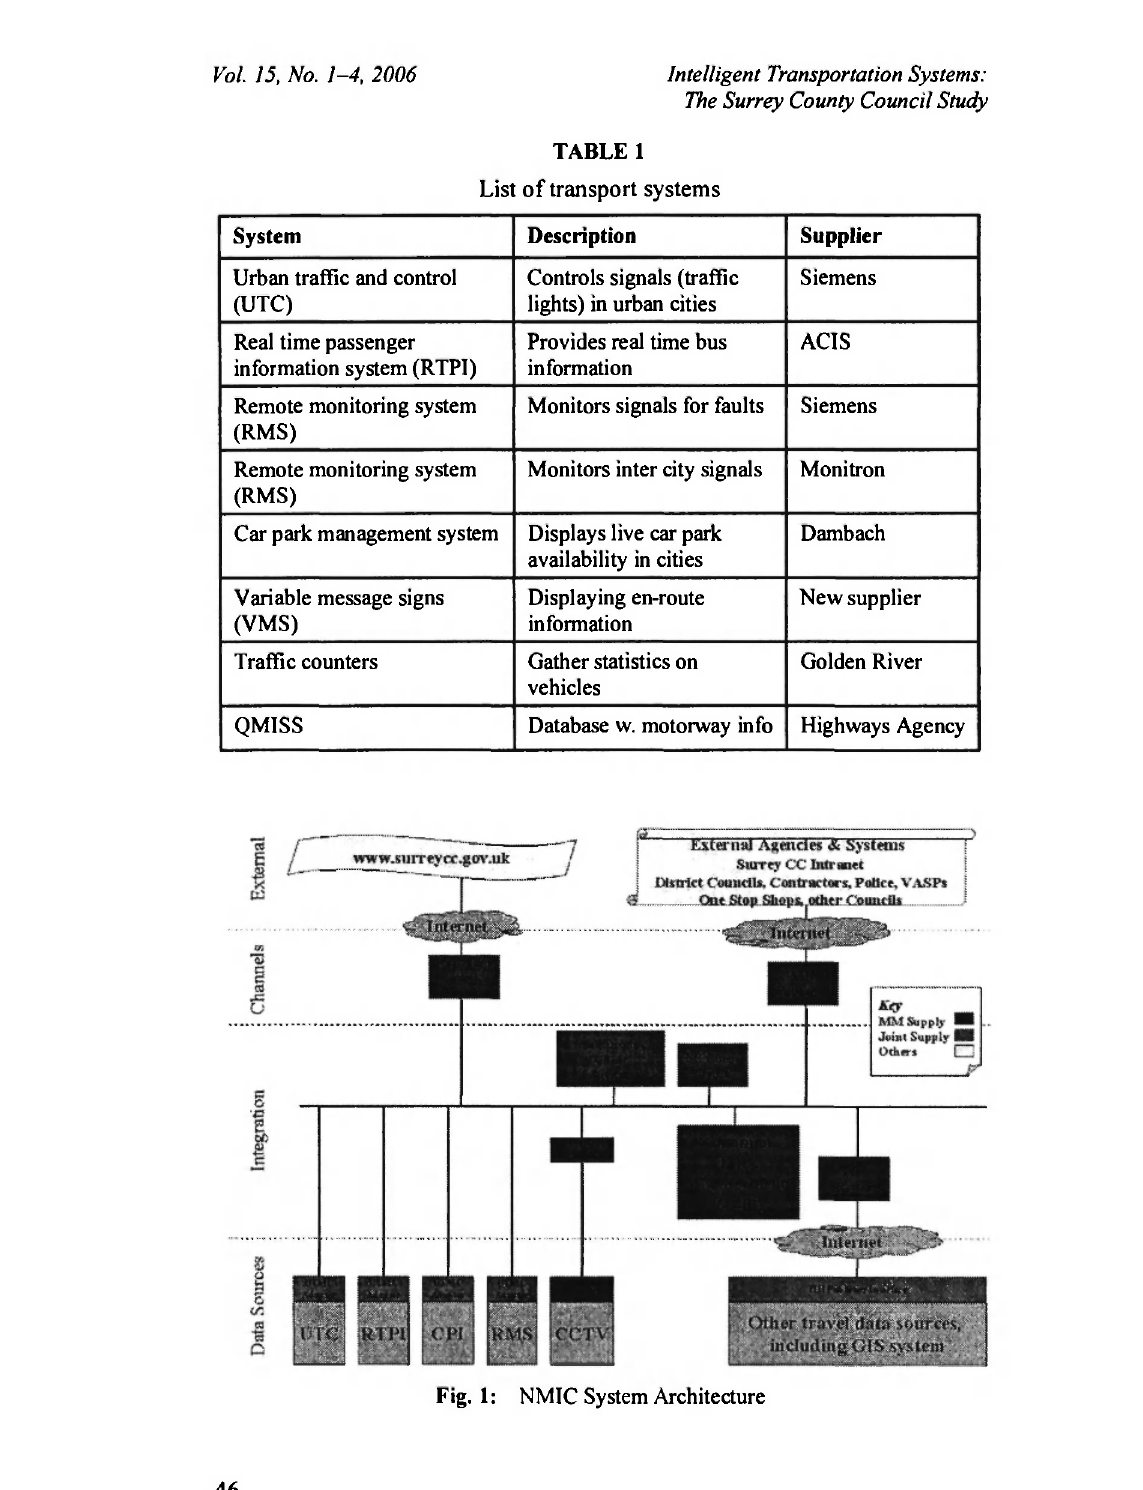
Fig. 1: NMIC System